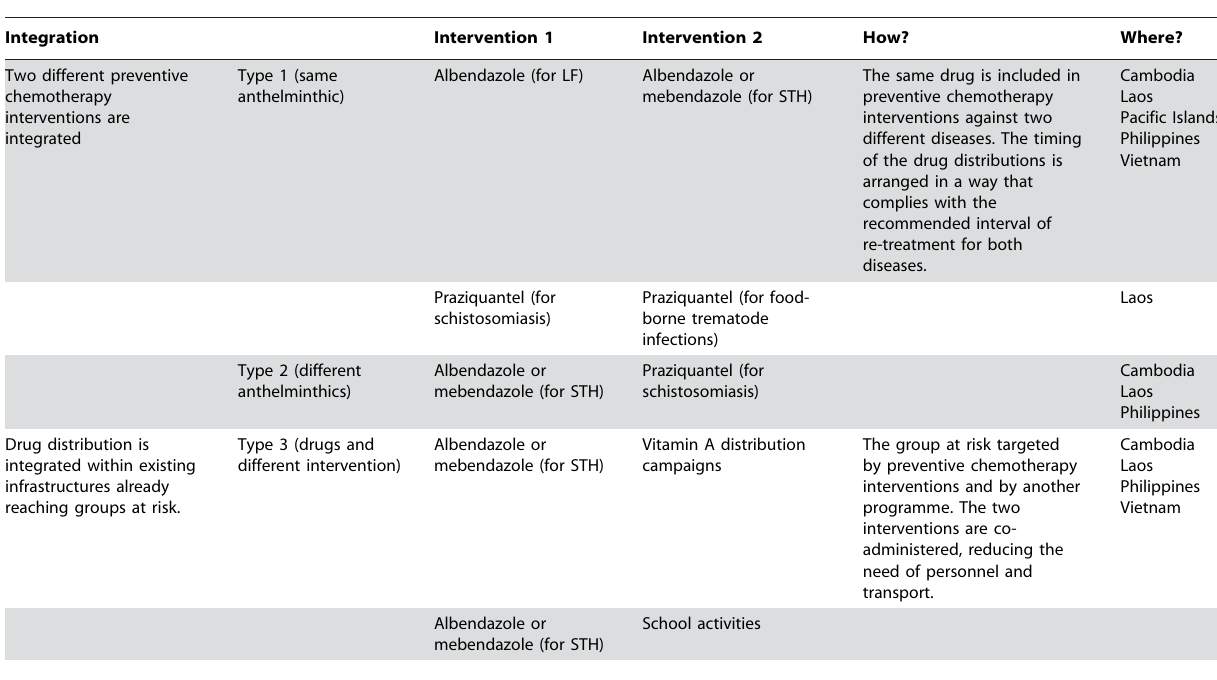
Table 4. Different Kinds of Integration for the Control of NTDs Is Occurring in the WPR